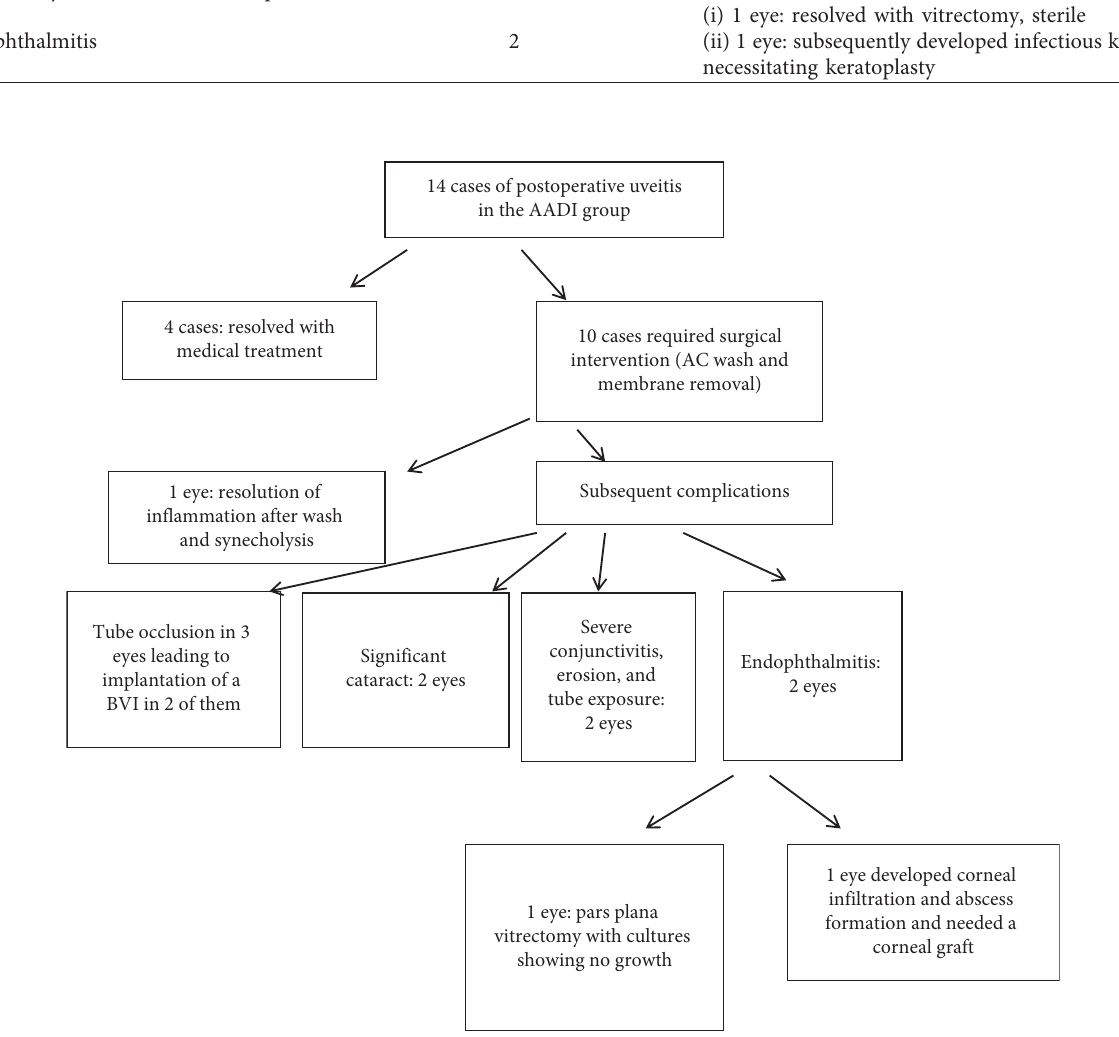
Figure 5: Flowchart summarizing the fate of the postoperative reaction noted in some of the study